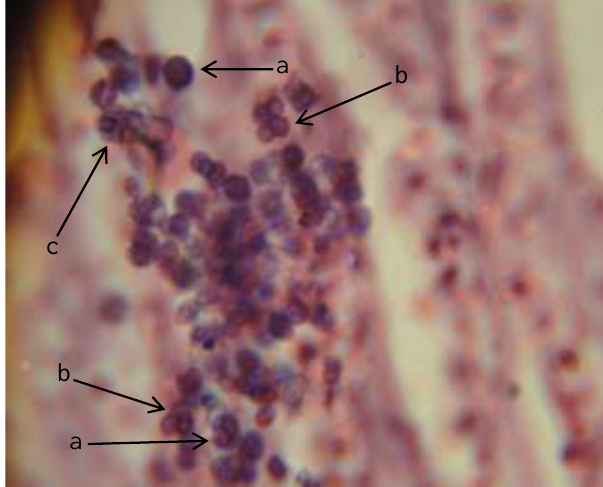
Figure 8: Histological section of gill Cyprinus carpio infected with Branchiomyces spp. , revealing heavily proliferated gill filaments (arrows): H & E 400 X.